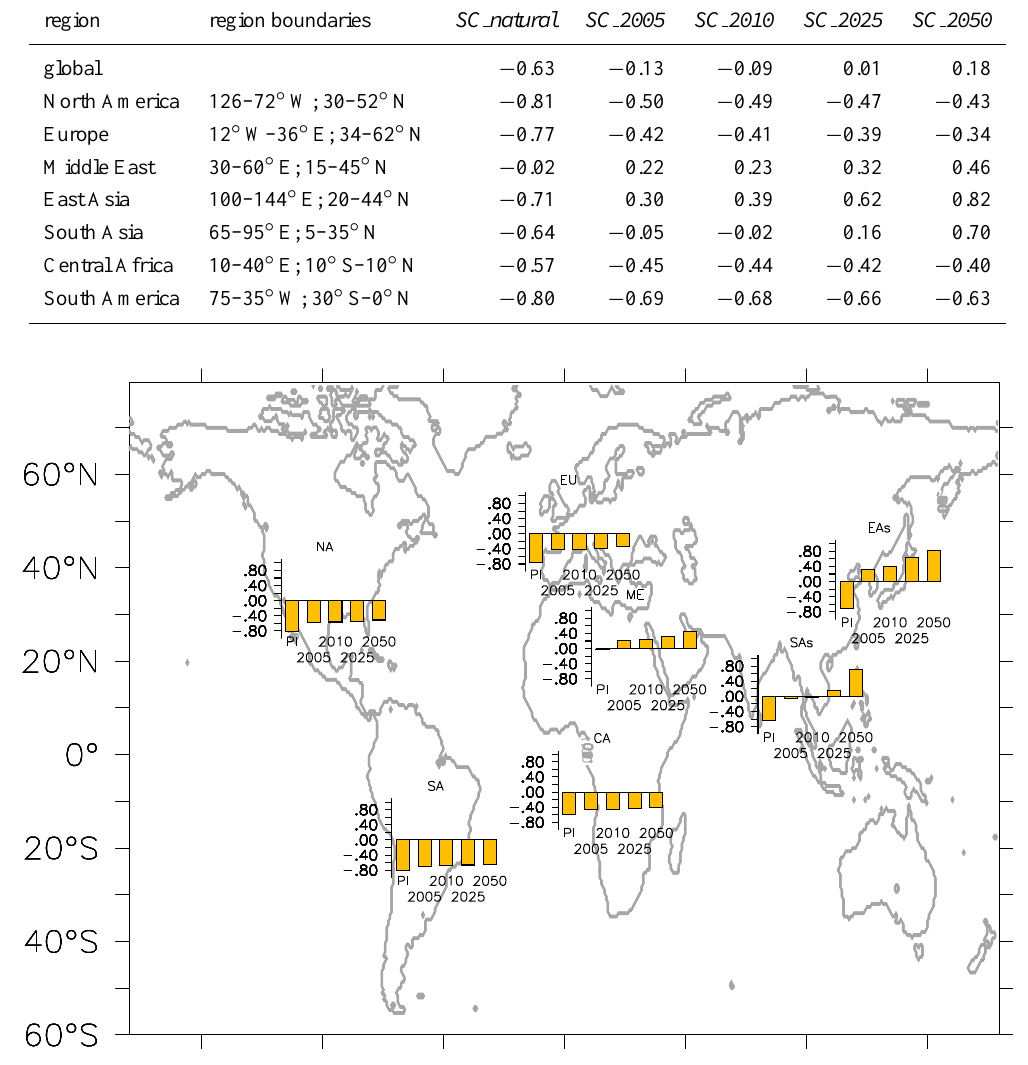
Table 5. PW-MPI values for selected regions.